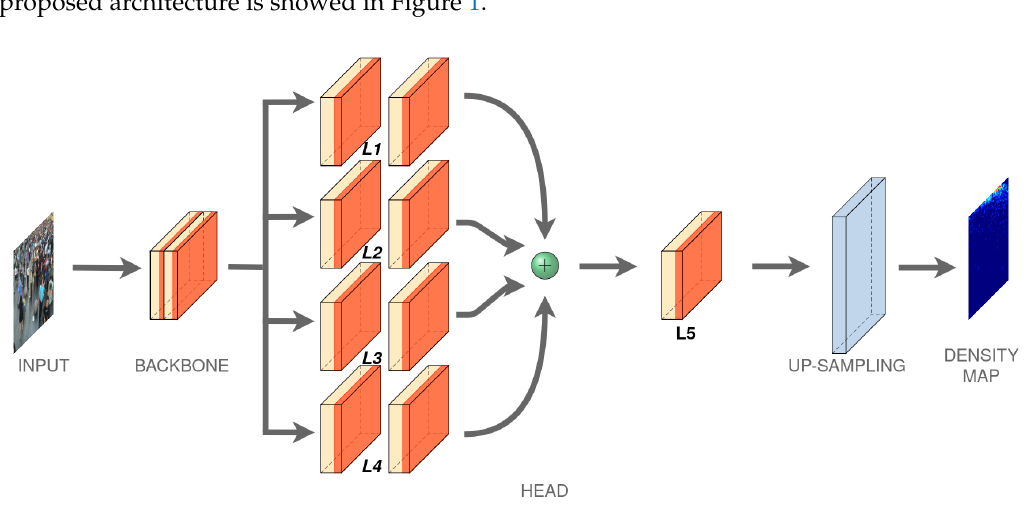
Figure 1. Proposed MH-MetroNet